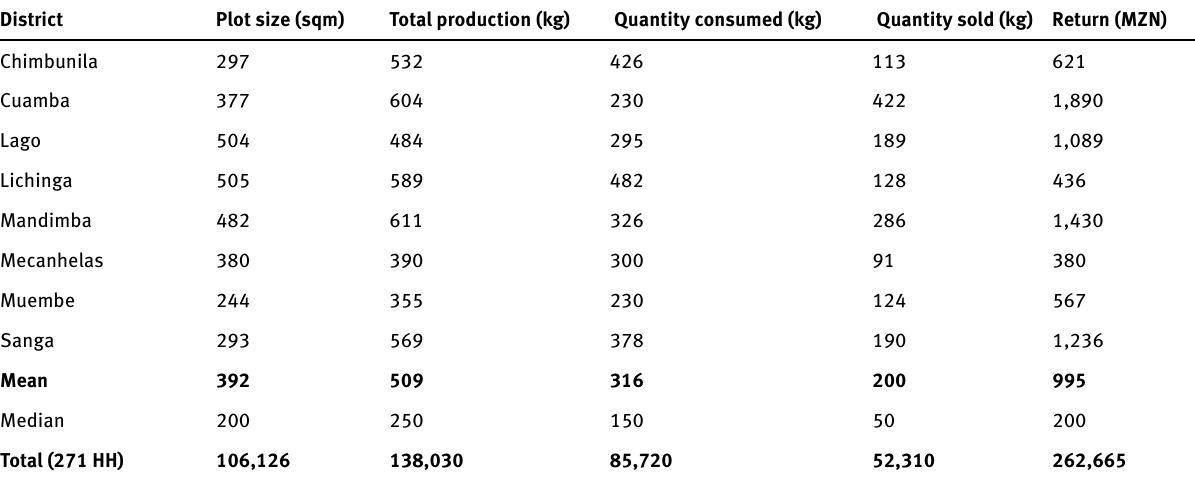
Figure 6: OFSP vine conservation in upland field Table 2: Means of plot size, production, quantity of OFSP roots consumed, sold and returned per household District Plot size